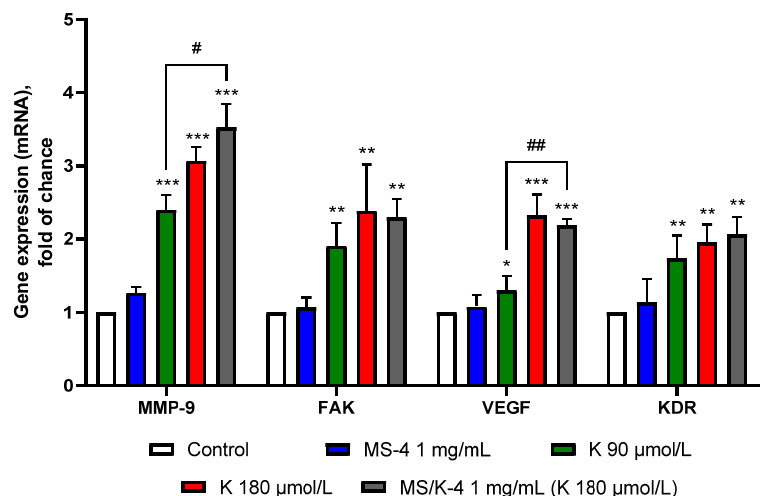
Figure 11. MS/K-4 induced the expression of pro-angiogenic genes in human endothelial cells. HMEC-1 was treated with MS/K4, free LYS, or MS-4 for 24 h at the concentrations indicated. The total RNA was then extracted from cells, and the mRNA levels of MMP-9, FAK, VEGF, and KDR were measured via qPCR using specific primers and normalized to GAPDH RNA. Data (means ± S.D.; n = 3) were expressed as fold induction over the basal (untreated) control. * p < 0.05 versus basal (untreated) control; ** p < 0.01 vs. basal (untreated) control; *** p < 0.001 vs. basal (untreated) control; # p < 0.05 between joined bars; ## p < 0.01 between joined bars.